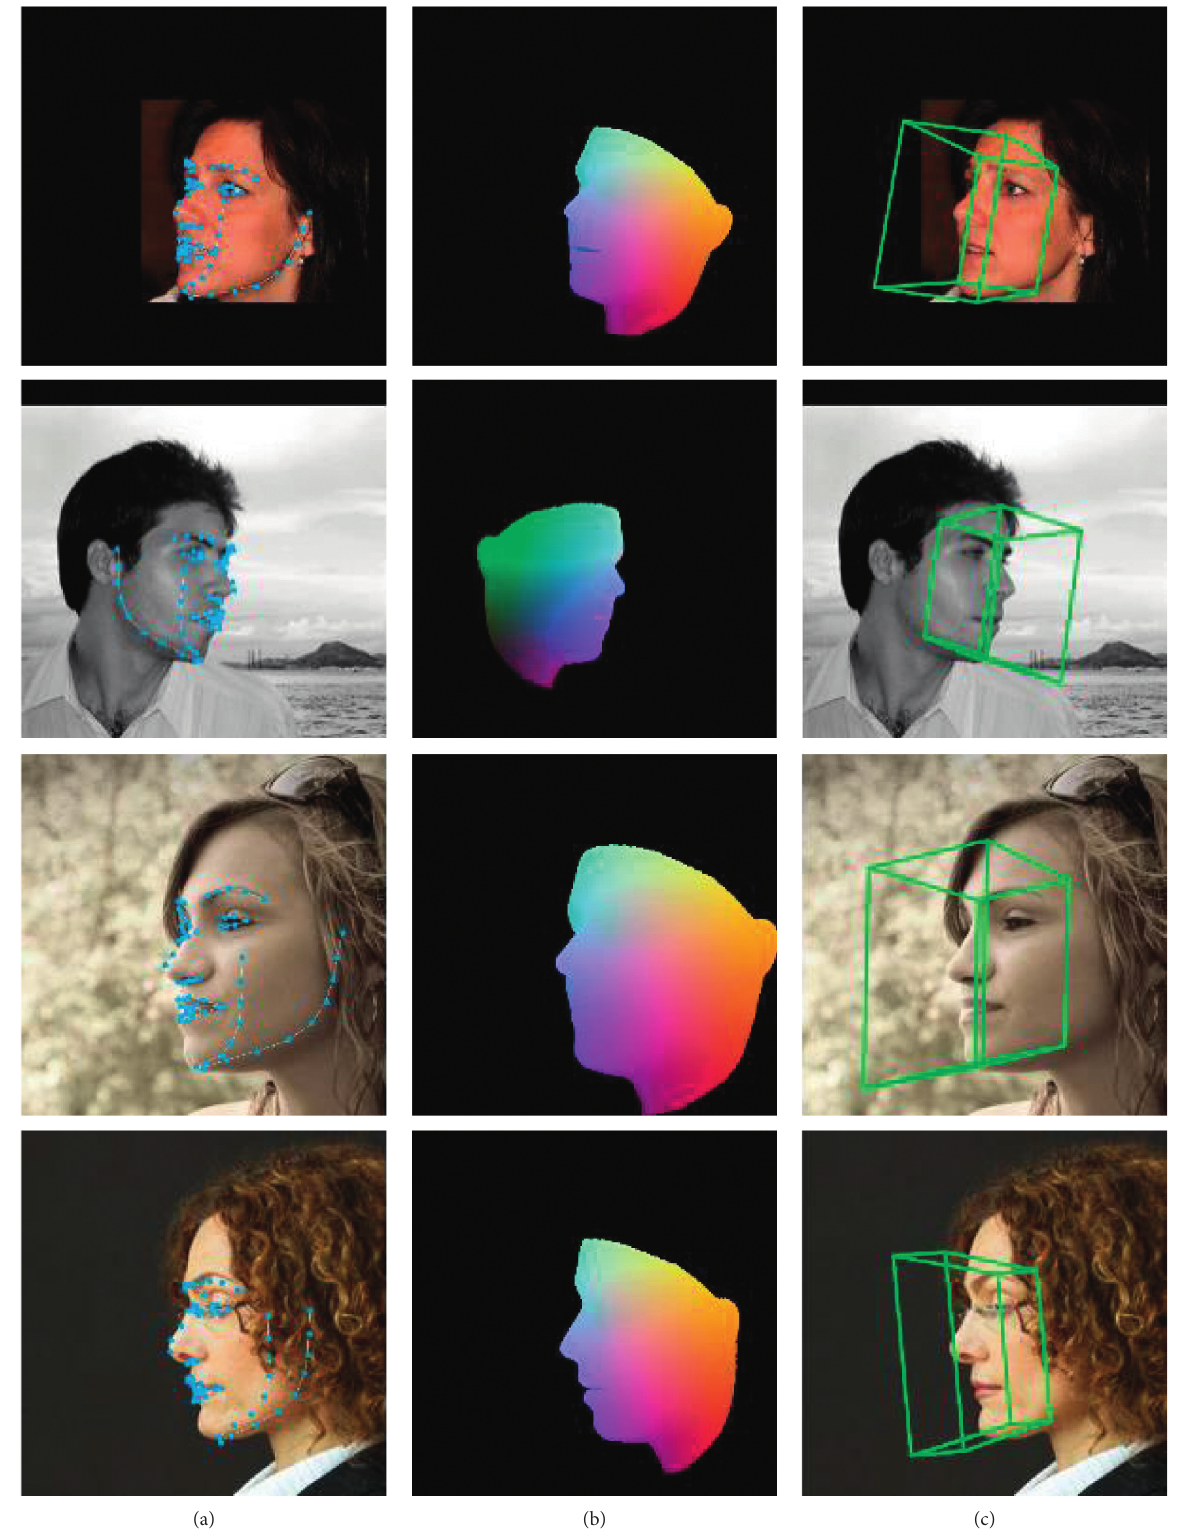
Figure 9: [60 ° , 90 ° ], large-pose face alignment